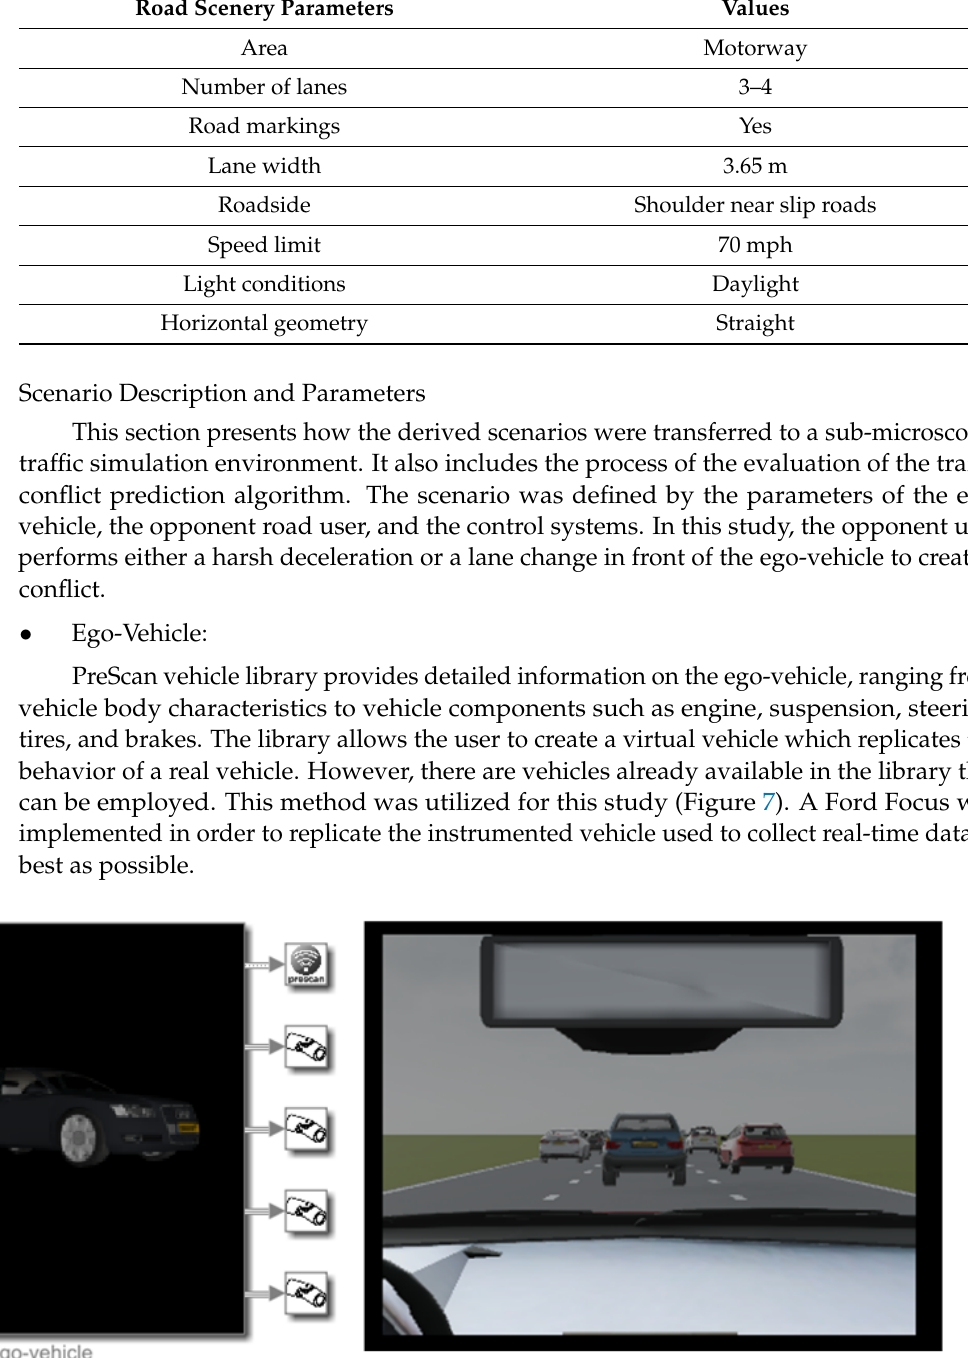
Figure 7. The ego-vehicle used in the simulation framework. A table containing all the important ego-vehicle parameters is presented in Table 3. Table 3. Ego-vehicle ’ s parameter setup.